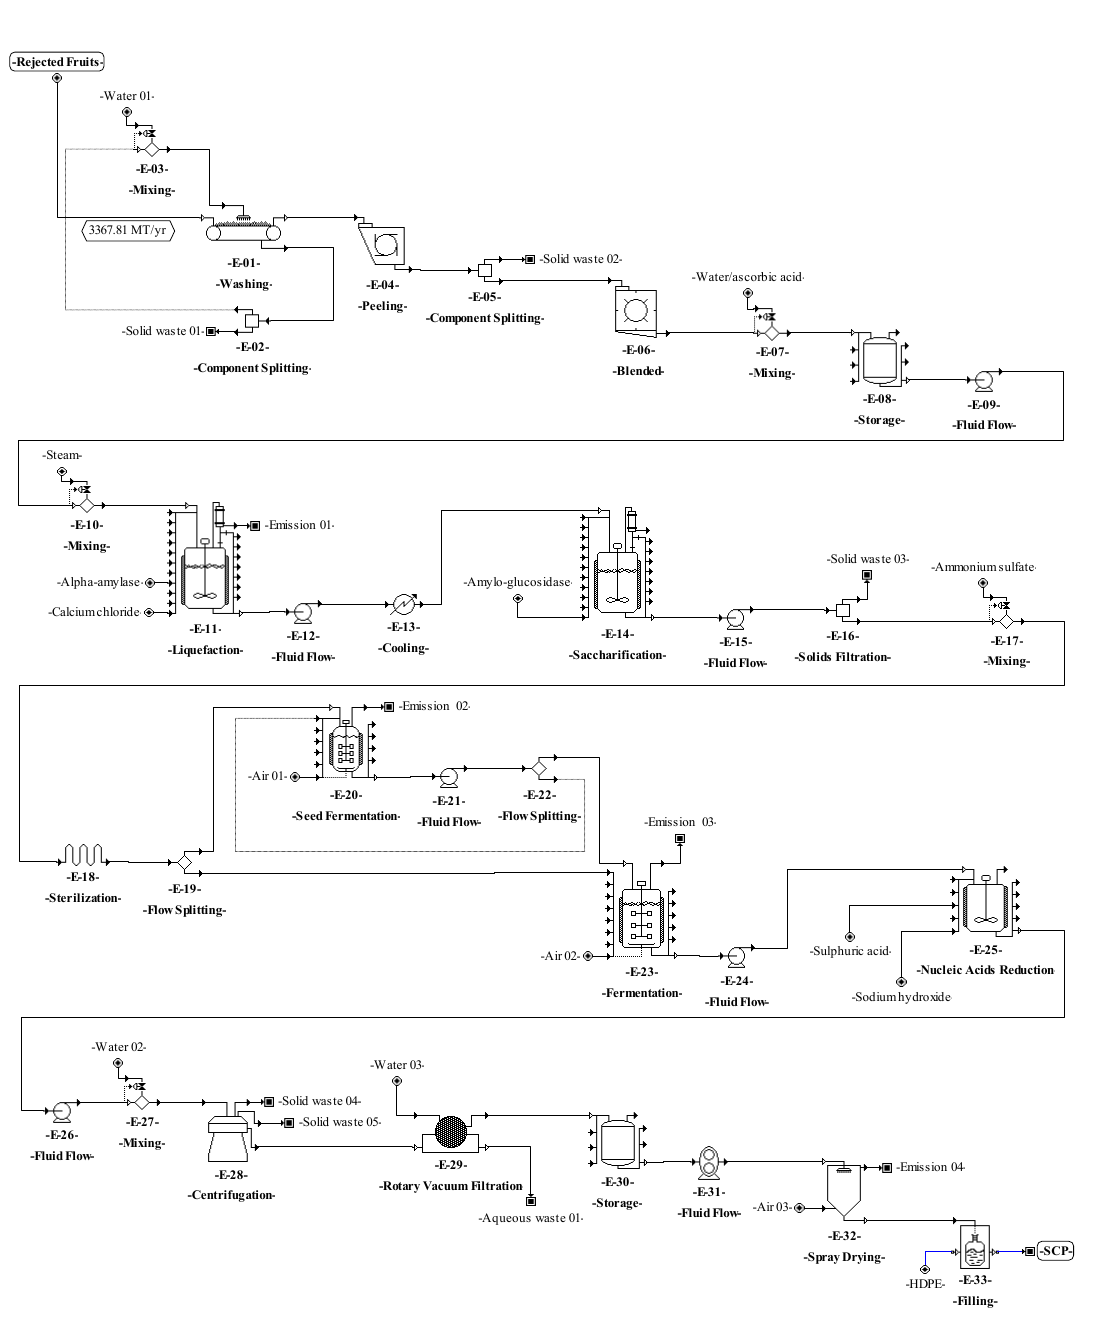
Figure 5. Process flowsheet of single-cell protein (SCP) production from rejected unripe plantain fruits.